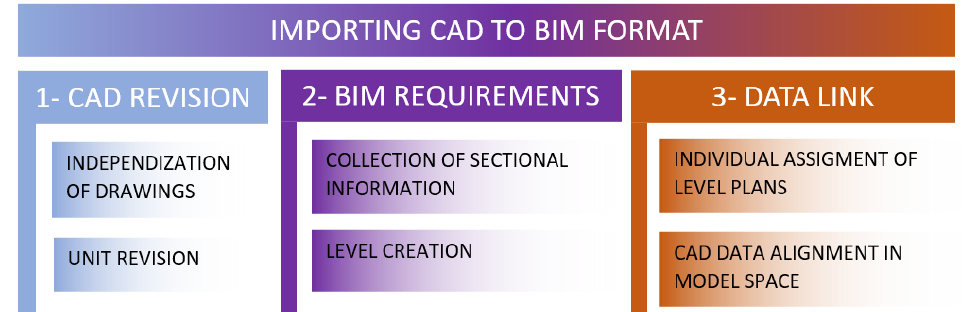
Figure 2. Flow char of CAD to BIM information transformation.